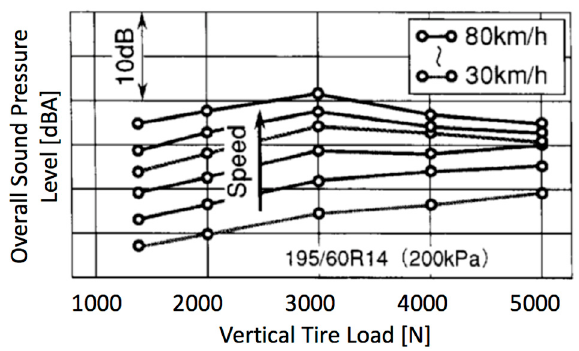
Figure 5. Changes of tire noise due to tire load and speed (modified from Iwao and Yamazaki, 1996 [36], Figure 6).